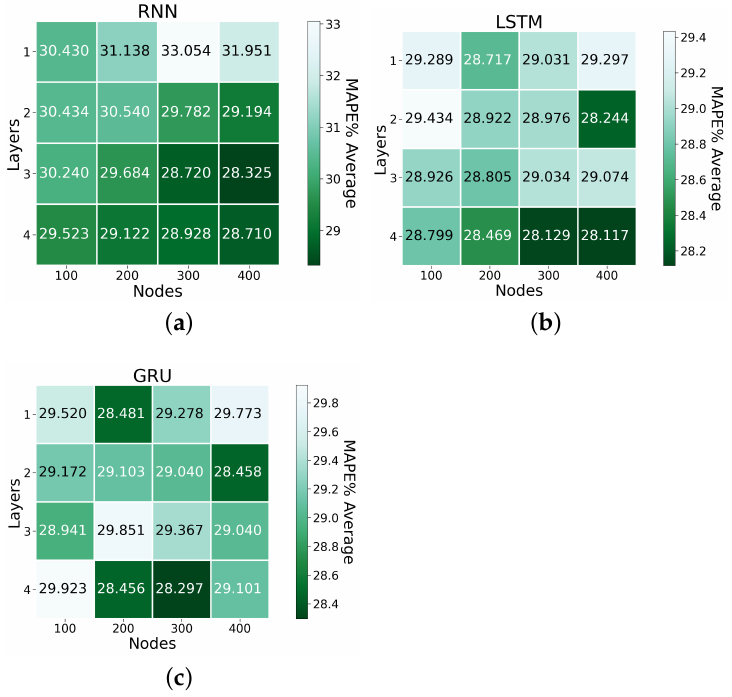
Figure 9. MAPE grid search result for ( a ) RNN; ( b ) LSTM; and ( c )